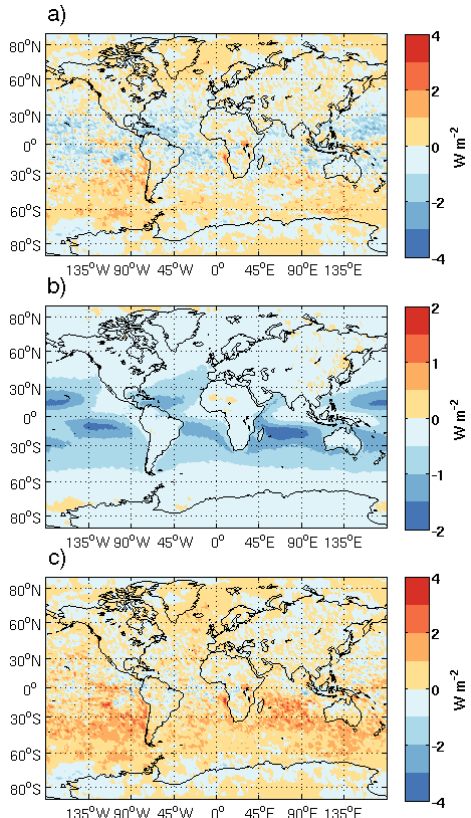
Figure 13. Radiative effects (5-year means) of sea spray aerosol in simulation ossa-ref . (a) Effective radiative forcing (total effect), (b) direct effect, (c) indirect